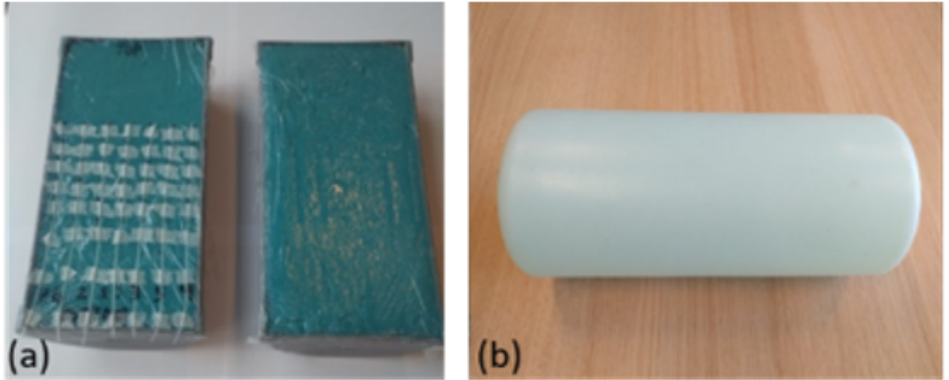
Figure 2. Phantoms ( a ) Cylindrical Split Phantom ( b ) Cylindrical MR